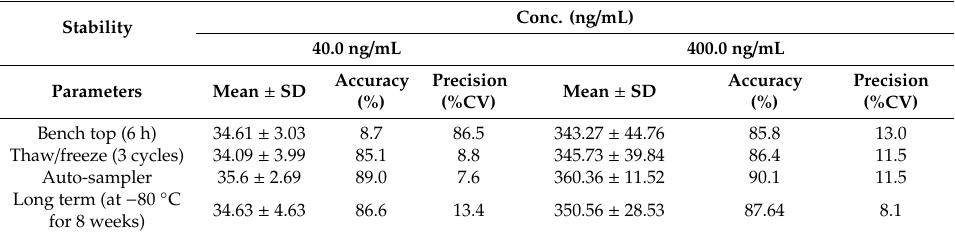
Table 3. Stability quality control sample of baracitinib in rat plasma ( n =